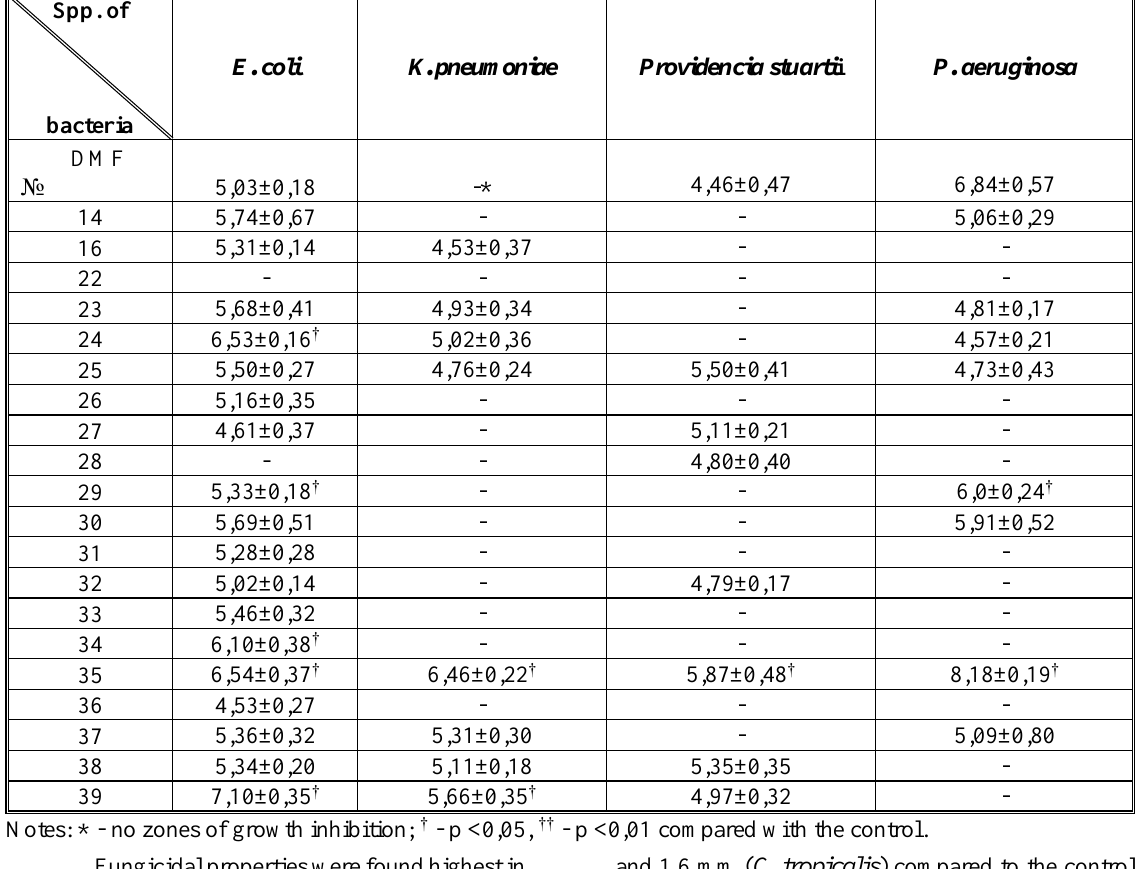
Table 3. Antimicrobial effect of synthesized compounds on Gram-negative bacteria Spp. of